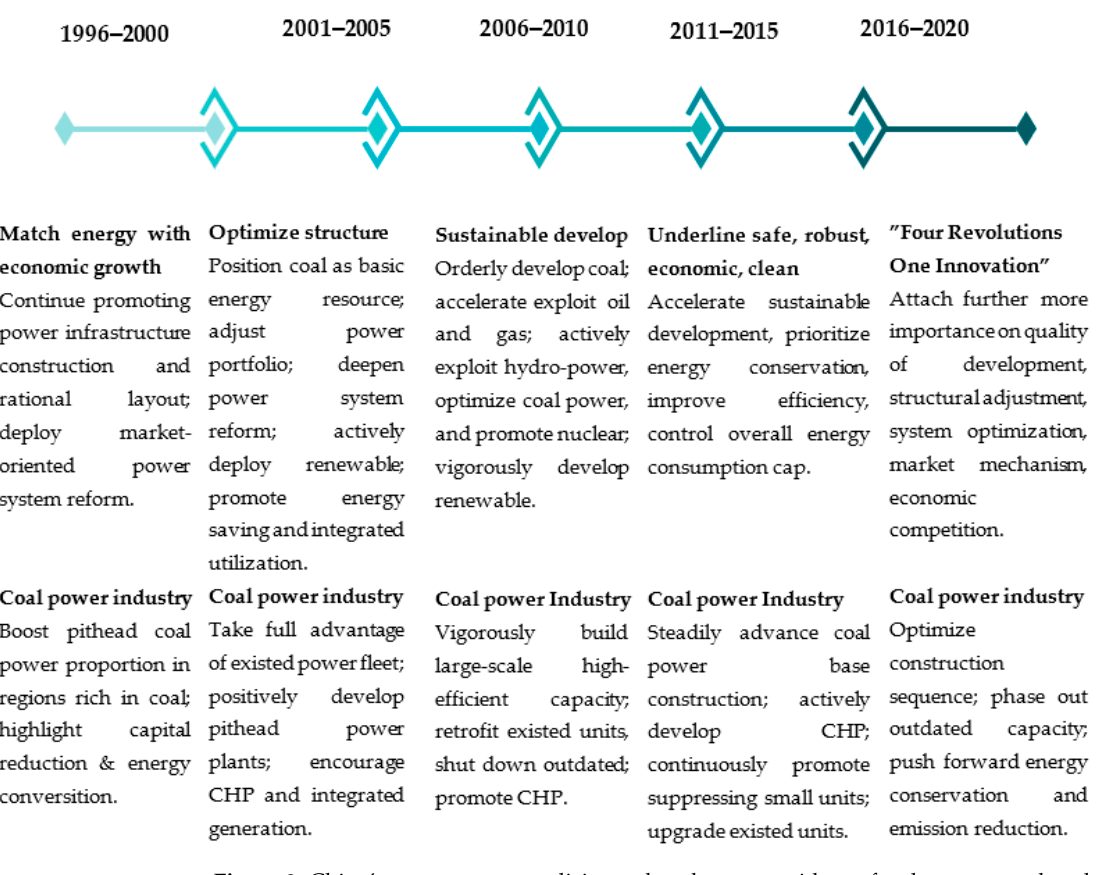
Figure 2. China’s macro-energy policies and coal power guidance for the past two decades.